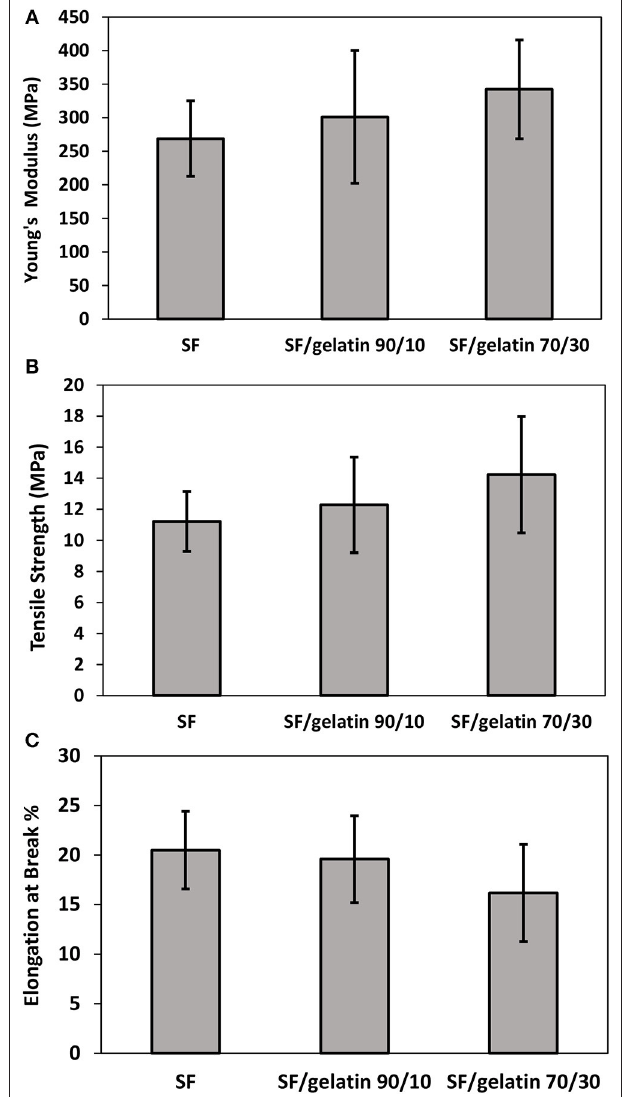
FIGURE 9 | Mechanical properties of GTA crosslinked SF nanofiber mats and SF/gelatin nanofiber mats: (A) Young’s modulus, (B) tensile strength, and (C) elongation at